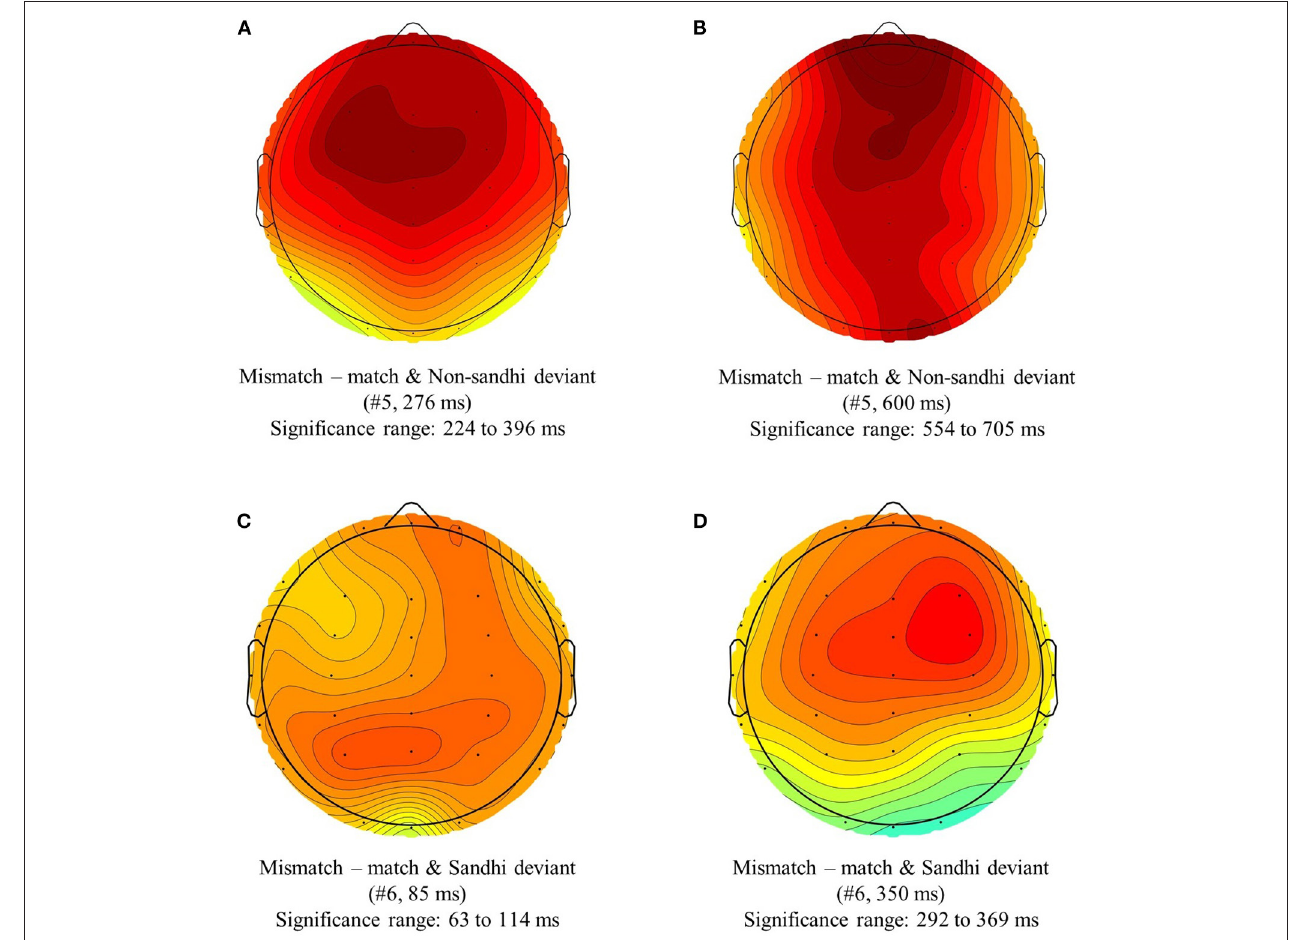
FIGURE 4 | Topographic distribution of the significant positive clusters found in the waveforms Mismatch—match and Non-sandhi deviant (#5), and Mismatch—match and Sandhi deviant (#6), at visually identified positive peaks. Panel (A) shows a positive cluster in #5 (Mismatch—match and Non-sandhi deviant), peaked at 276ms, and ranged from 224ms to 396ms. Panel (B) shows another positive cluster in #5 (Mismatch—match and Non-sandhi deviant), peaked at 600ms, and ranged from 554ms to 705ms. Panel (C) shows a positive cluster in #6 (Mismatch—match and Sandhi deviant), peaked at 85ms, and ranged from 63ms to 114ms. Panel (D) shows another positive cluster in #6 (Mismatch—match and Sandhi deviant), peaked at 350ms, and ranged from 292ms to